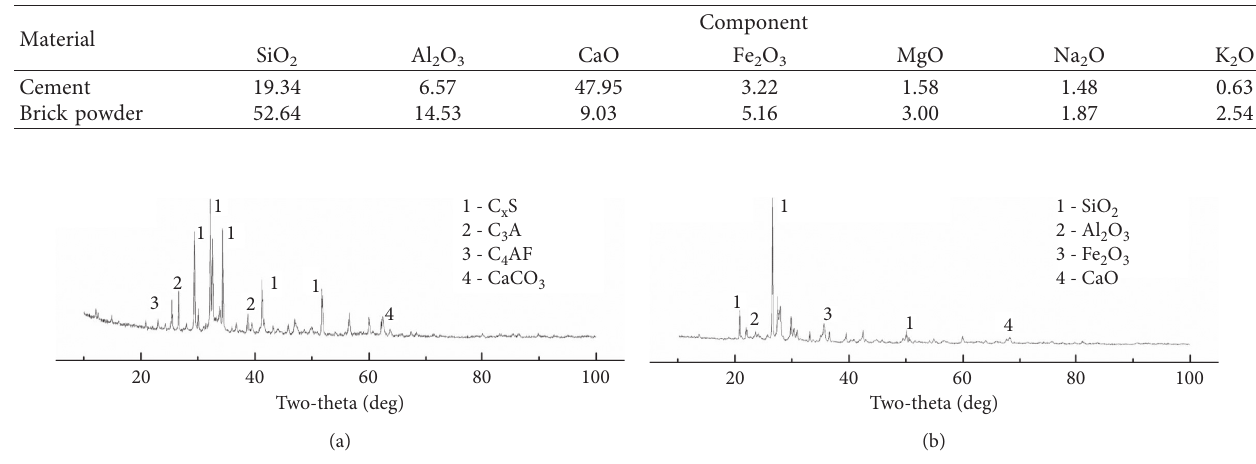
Table 1: Chemical compositions of cement and brick powder (by wt%).